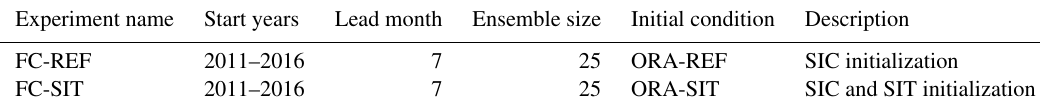
Table 2. Overview of the reforecast experiments. For each of the start years, forecasts are started on the first of every calendar month.